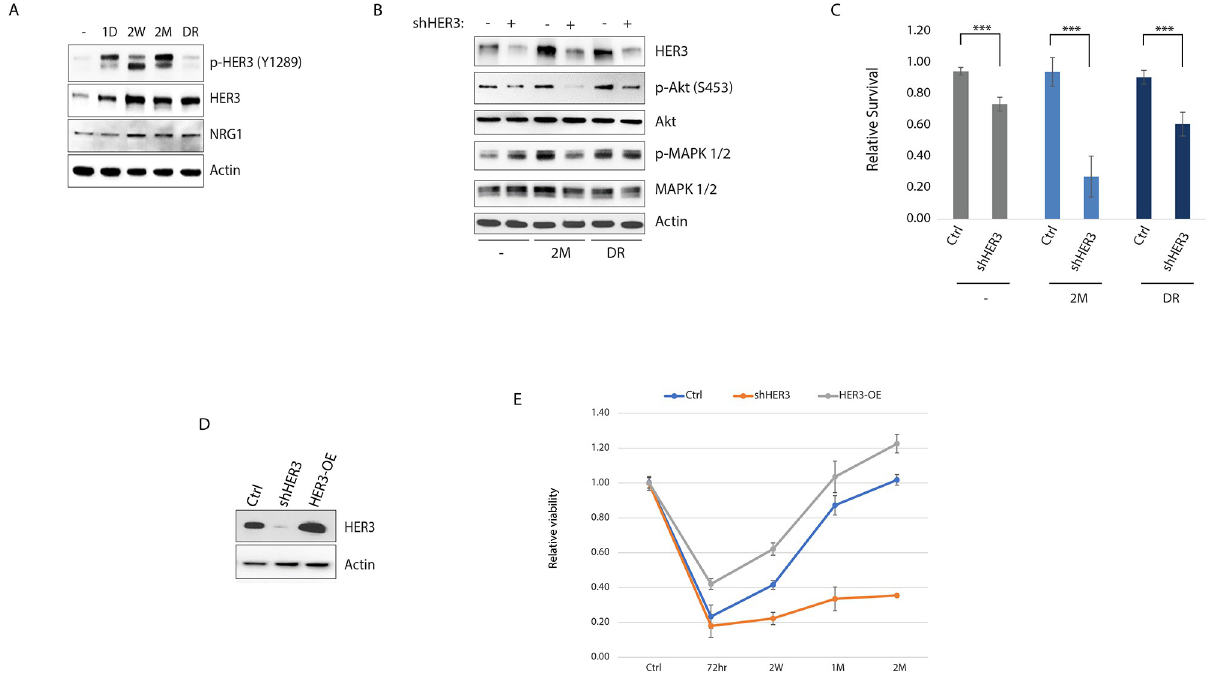
Fig 2. Her3 overexpression confers tumor cell growth under lapatinib. A) Total and phospho-Her3 levels at the indicated stages of lapatinib (1 μ M) treatment. B) Western blot of the indicated signaling proteins with and without shRNA-mediated knock-down of Her3 at the indicated stages of lapatinib treatment. C) Relative viability (compared to control) under the same conditions. D) Her3 was stably silenced or overexpressed in SKBR3 cells, and E) the relative cell growth (relative to control) was calculated after 1 μ M lapatinib treatment for the indicated time period. Statistics: error bars show standard deviations of 6 (C) or 3 (E) replicate experiments. ��� : P < 0.01 with student’s t-test. Densitometric quantitation of the immunoblotting data are provided in S1 Table.